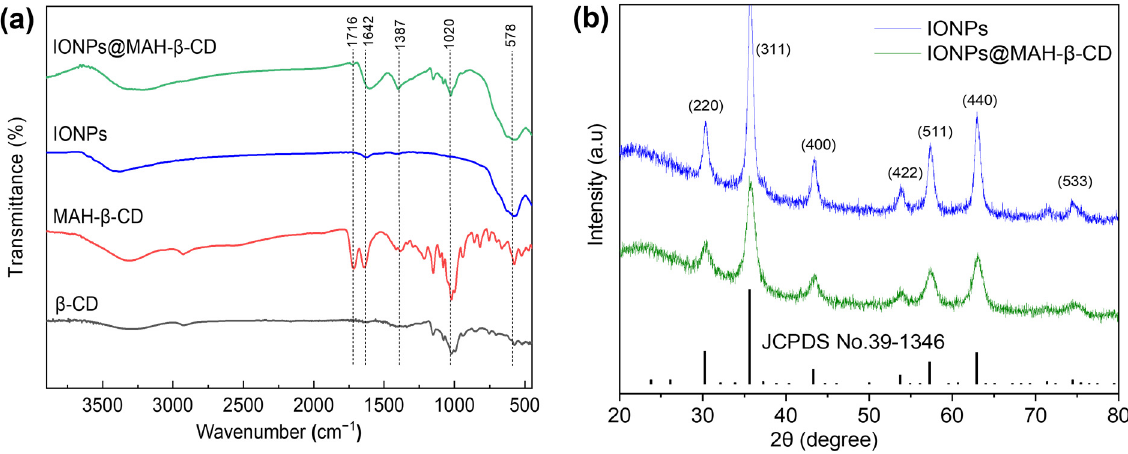
Figure 1. FTIR spectra ( a ) and XRD patterns ( b